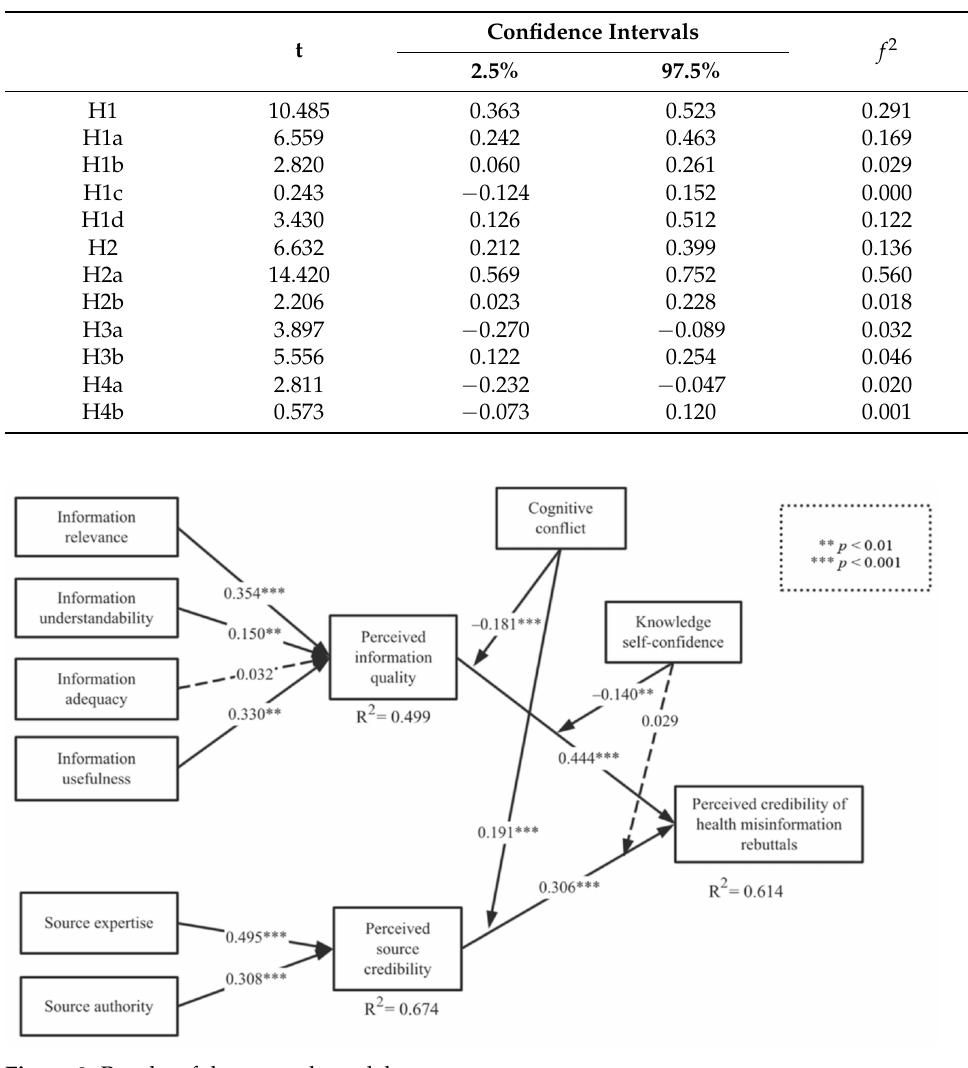
Figure 3. Results of the research